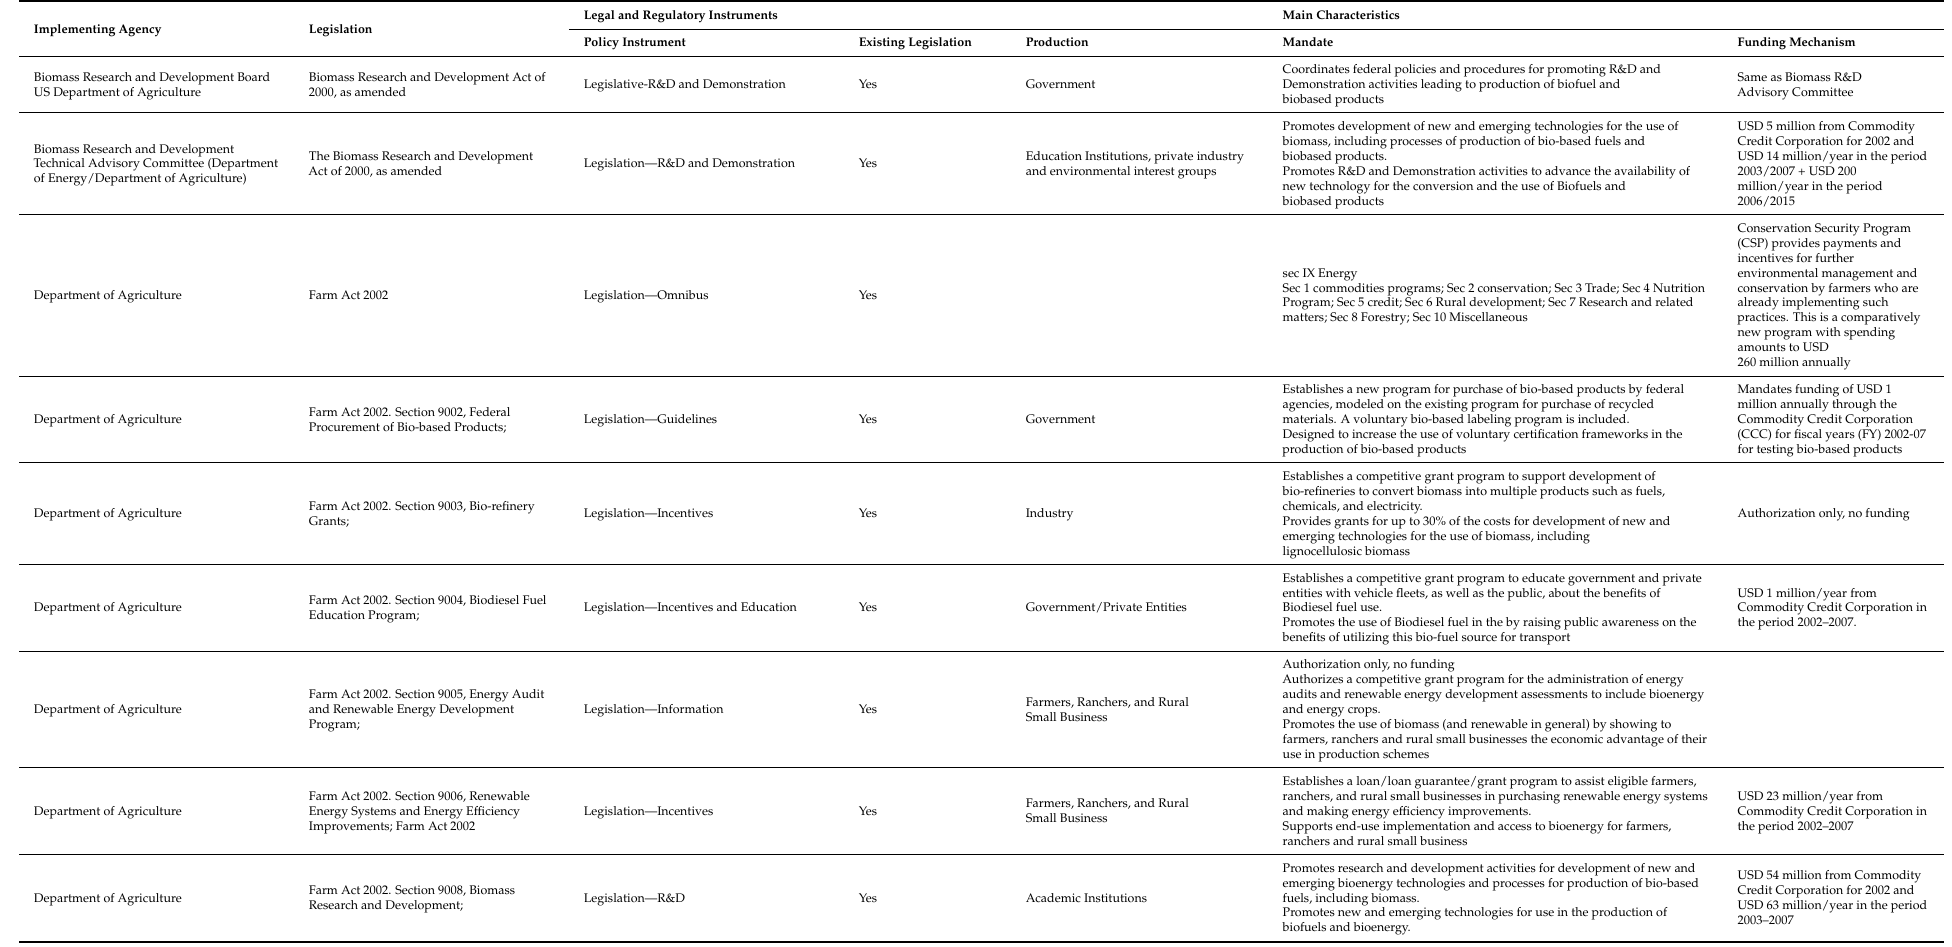
Table A1. Summary of the U.S. main legislation enacted by the U.S. Congress for Forest